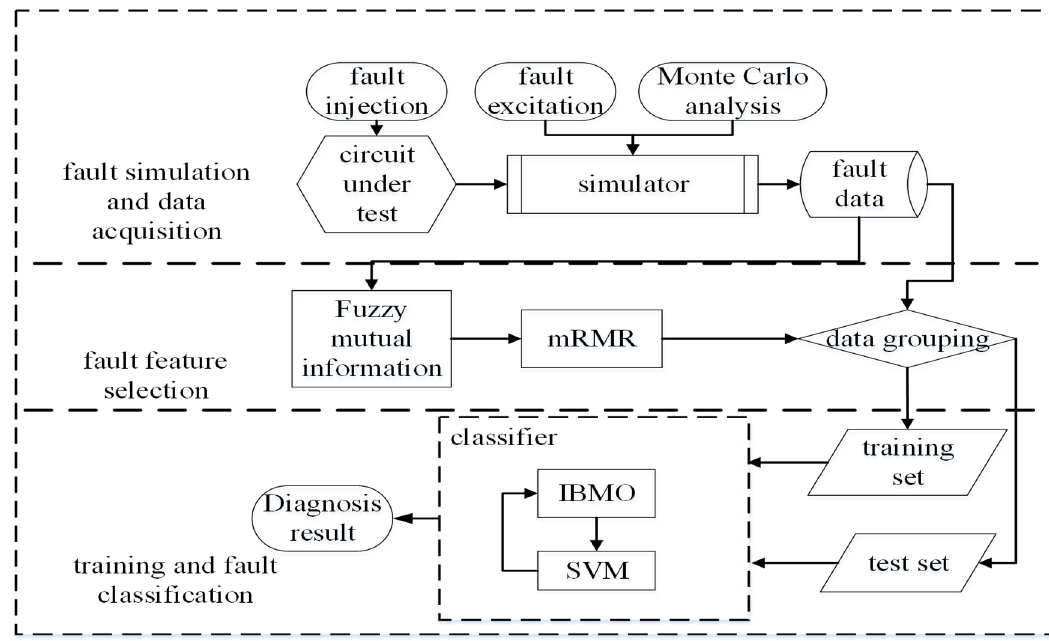
Figure 3. Diagram of the analog circuit fault diagnosis